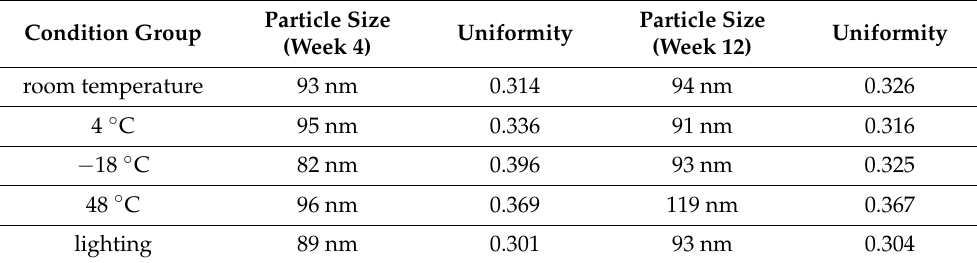
Table 1. E-AGSE particle size under different